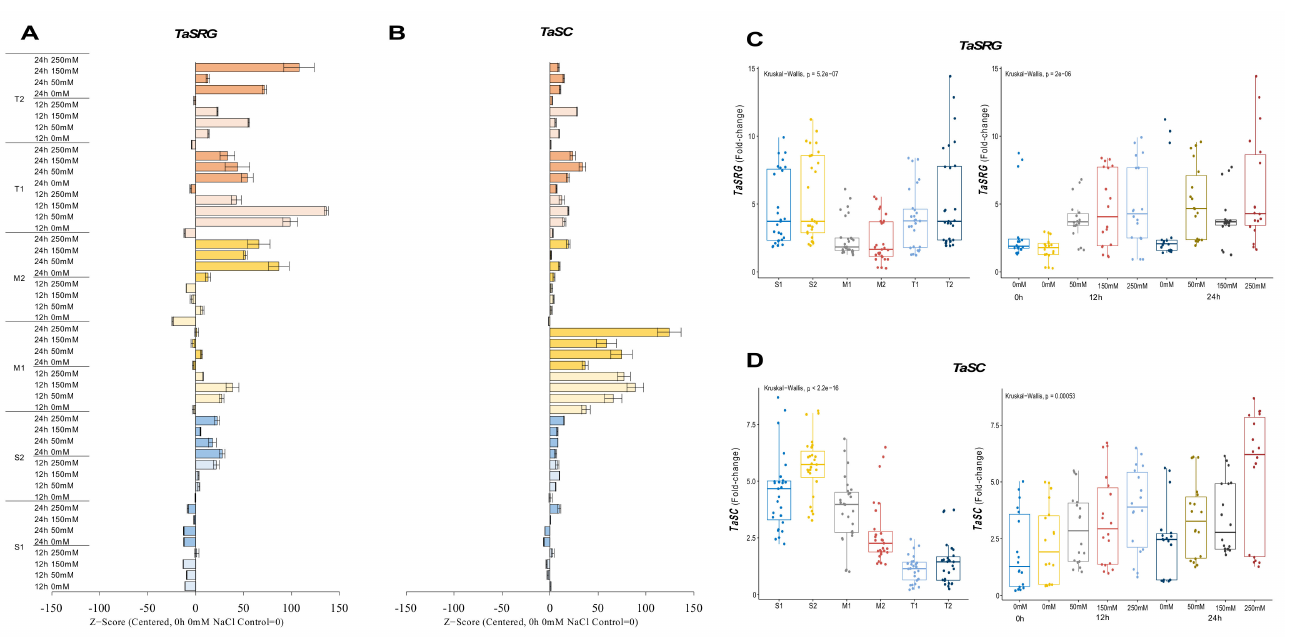
Figure 3. The expression of TaSRG and TaSC genes. ( A ) The gene expression pattern of TaSRG and ( B ) TaSC genes; ( C ) the total gene expression profile of TaSRG for genotypes, salt stress, and time course; ( D ) the total gene expression profile of TaSC for genotypes, salt stress, and time course. The Cq values formed the basis of qRT-PCR. The reference gene TaACTIN was used to standardize the Cq value for each sample. Z-score centered to 0 h 0 mM treatment (Control = 0). Values represent the means ± SD ( n =